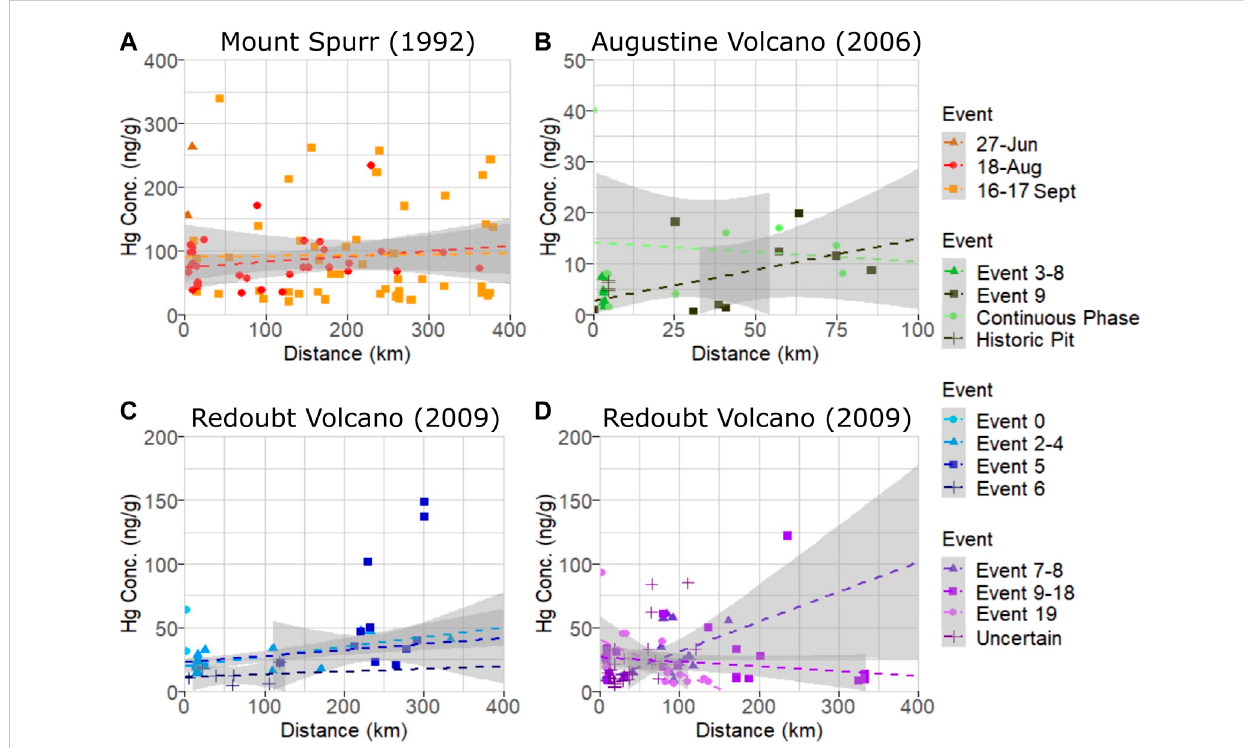
FIGURE 2 Plot of Hg concentration measured as PBM on volcanic ash versus distance for individual events within (A) Mount Spurr (B) Augustine Volcano, and (C,D) Redoubt Volcano(separated toavoid plotcrowding) eruptions.Dashedlinesare linearmodel fi tsused indetermining signi fi cance andgreyshaded areas are 95% con fi dence intervals. Note the high variance in measured PBM for each eruptive event and occurrence of sample Hg concentrations plotting outside 95% con fi dence interval regions indicating no signi fi cant relationship between Hg concentration and distance for these